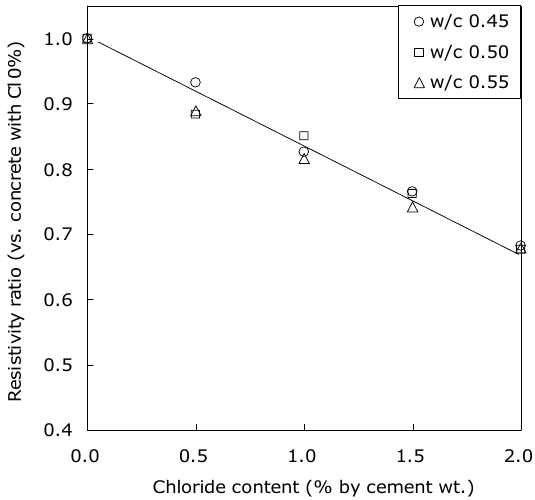
Figure 12. E ff ect of chloride concentration on the resistivity of Figure 12. Effect of chloride concentration on the resistivity of concrete.